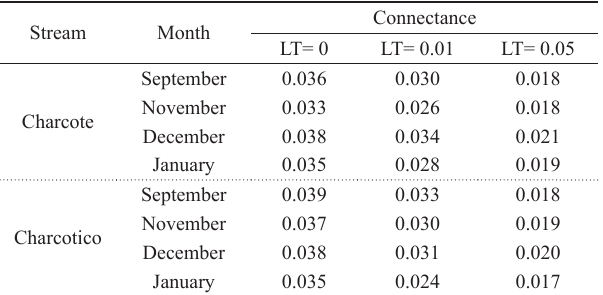
Fig. 4. Scatterplots (modified Costello diagram) showing the frequency of occurrence (FO) and relative abundance (RA) of prey items ingested by the entire fish assemblage in the Charcote (upper) and Charcotico (bottom) streams. Arrows indicate changes in the FO and RA of food items between months. Symbols indicate different types of food items. Bar charts (right side) highlight variation in the importance (FO+RA) of allochthonous materials (terrestrial invertebrates and vegetation) in fish diets. The low- water period is represented by January, high water by September, and falling water by November and Tab. 3 . Connectance of fish trophic networks in two Venezuelan Llanos streams during four survey periods. LT= link threshold, which defines the lower limit of the magnitude of trophic interactions (represented by proportional volume of dietary items in the diet of a given consumer during a given period) included in the connectance estimate. January was the low-water period, September was near the peak of the annual flood pulse, and during November and December floodwaters were gradually receding.